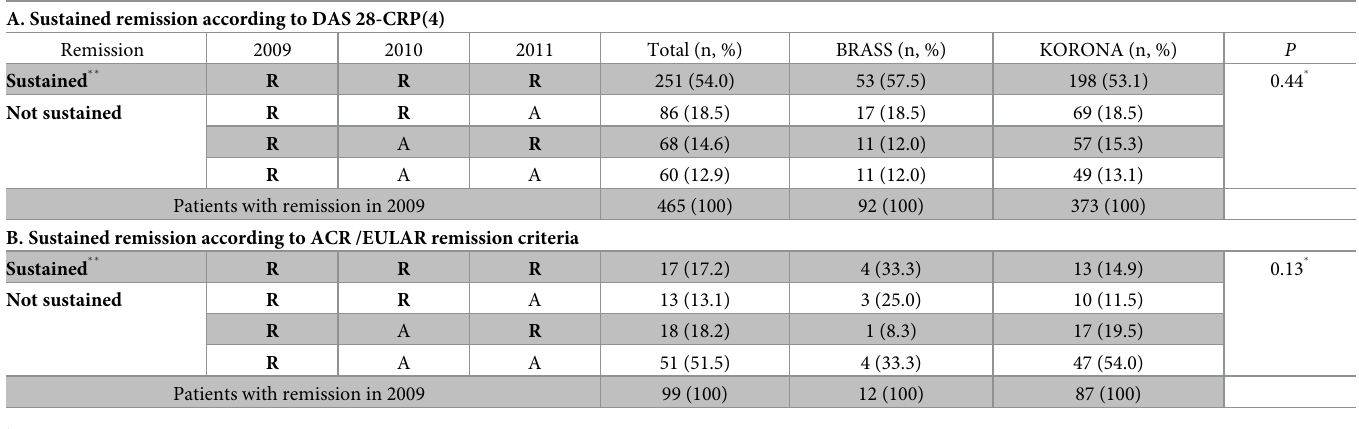
Table 2. Prevalence of sustained remission among patients with remission in